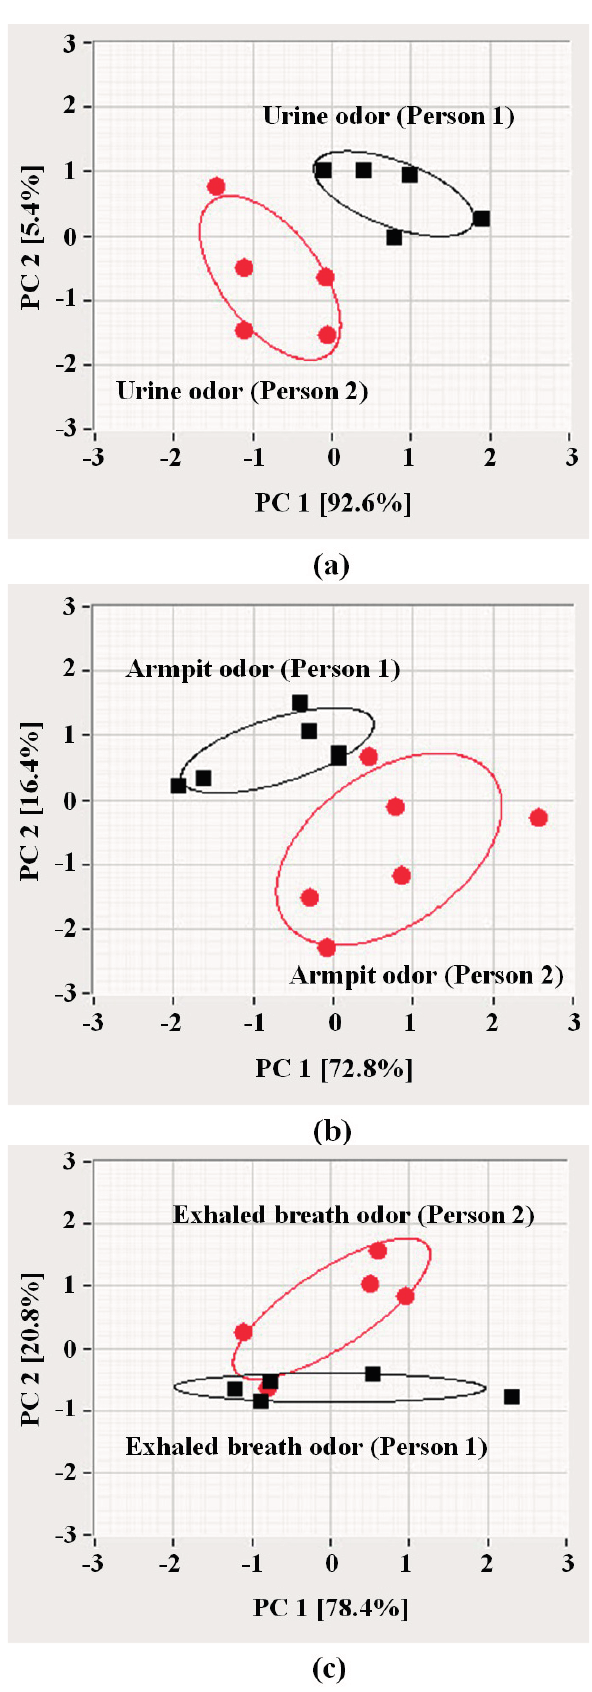
Figure 10. Principal component analysis (PCA) plot of the sensor data obtained from: ( a ) the urine odor; ( b ) the armpit odor; and ( c ) the exhaled breath odor of two male